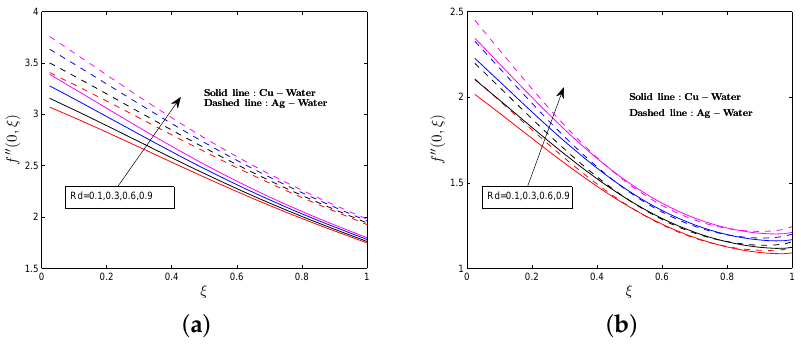
Figure 15. Skin friction coefficient for various values of Rd . ( a ) vertical plate; ( b ) horizontal